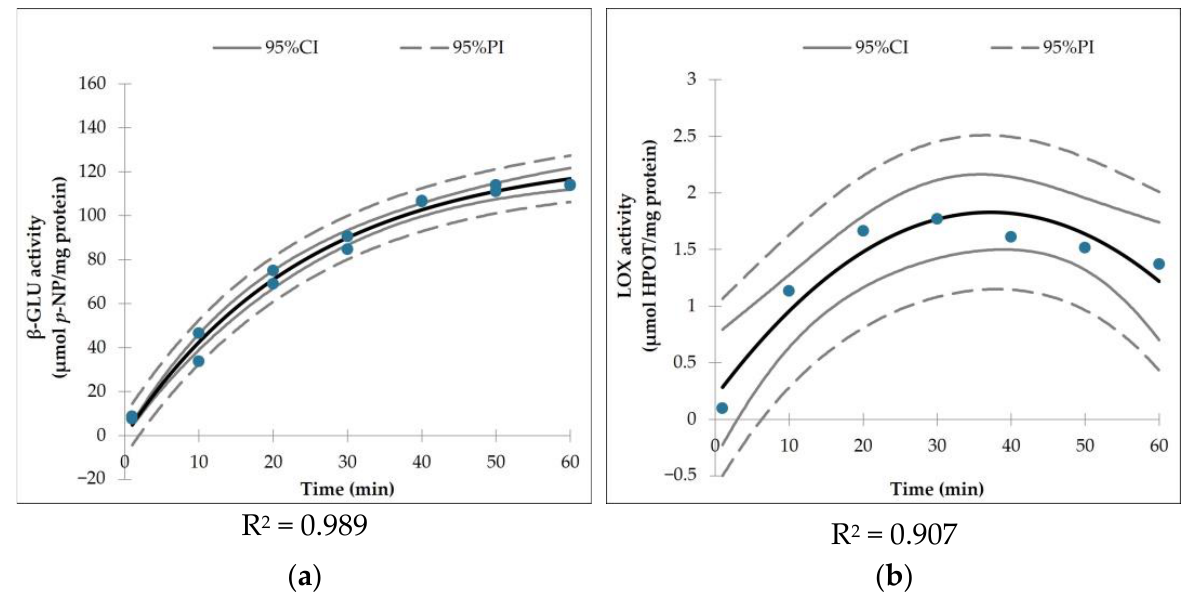
Figure 1. Nonlinear regression models for enzyme activity over time at 25 °C: ( a ) β-GLU—one phase association exponential function; ( b ) LOX—second-order polynomial function. The black line represents the model curve, the gray solid line (95% CI) represents the 95% confidence interval, and the gray dashed line (95% PI) represents the 95% prediction interval. The circles represent plot-level data points.